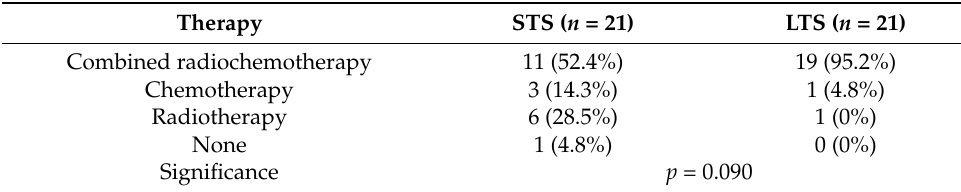
Table 4. Differences between STS and LTS (matched for WHO grade and molecular genetics):